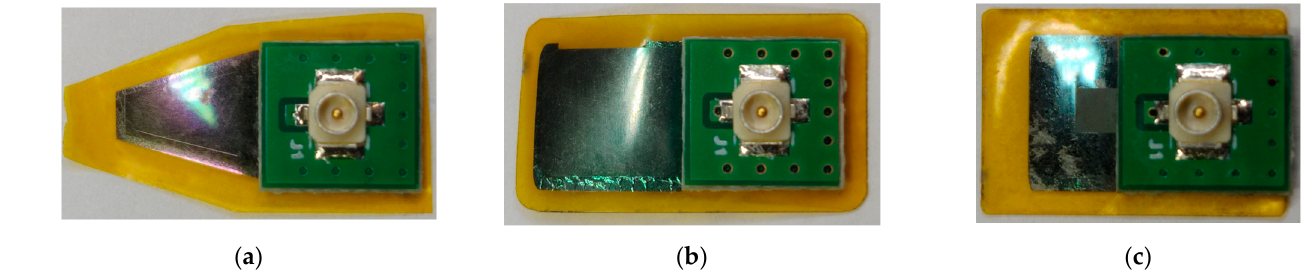
Figure 28. Three flexible AlN sensors used in the preliminary tests: triangular tip ( a ), large rectangular ( b ), and small rectangular ( c ).